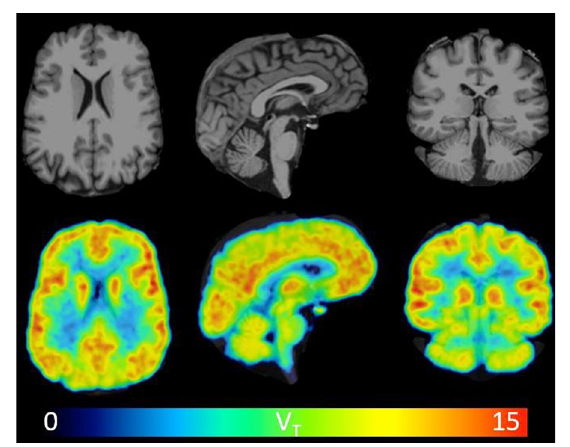
Fig. 4 Visual inspection of 11 C-CPPC total distribution volume ( V T ) values across the human brain reveals thalamus as one of the regions of highest binding, and relatively lower binding in cerebellar cortex. Parametric V T images and MRI images in three views are shown from a representative healthy participant. V T was estimated from 90-min data using Logan graphical analysis with the metabolite-corrected arterial input function. V T is in units of mL cm − 3 . The V T image was filtered with a 2 mm FWHM 3D Gaussian to reduce